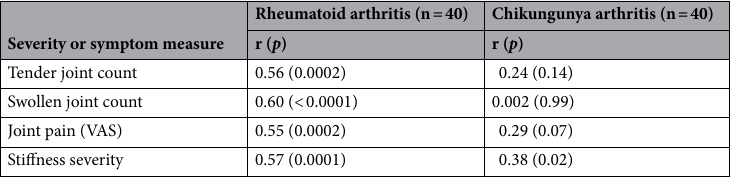
Table 2. Association of disease severity with HAQ disability index in rheumatoid and chikungunya arthritis. Results expressed as Spearman’s rank correlation coefficients.